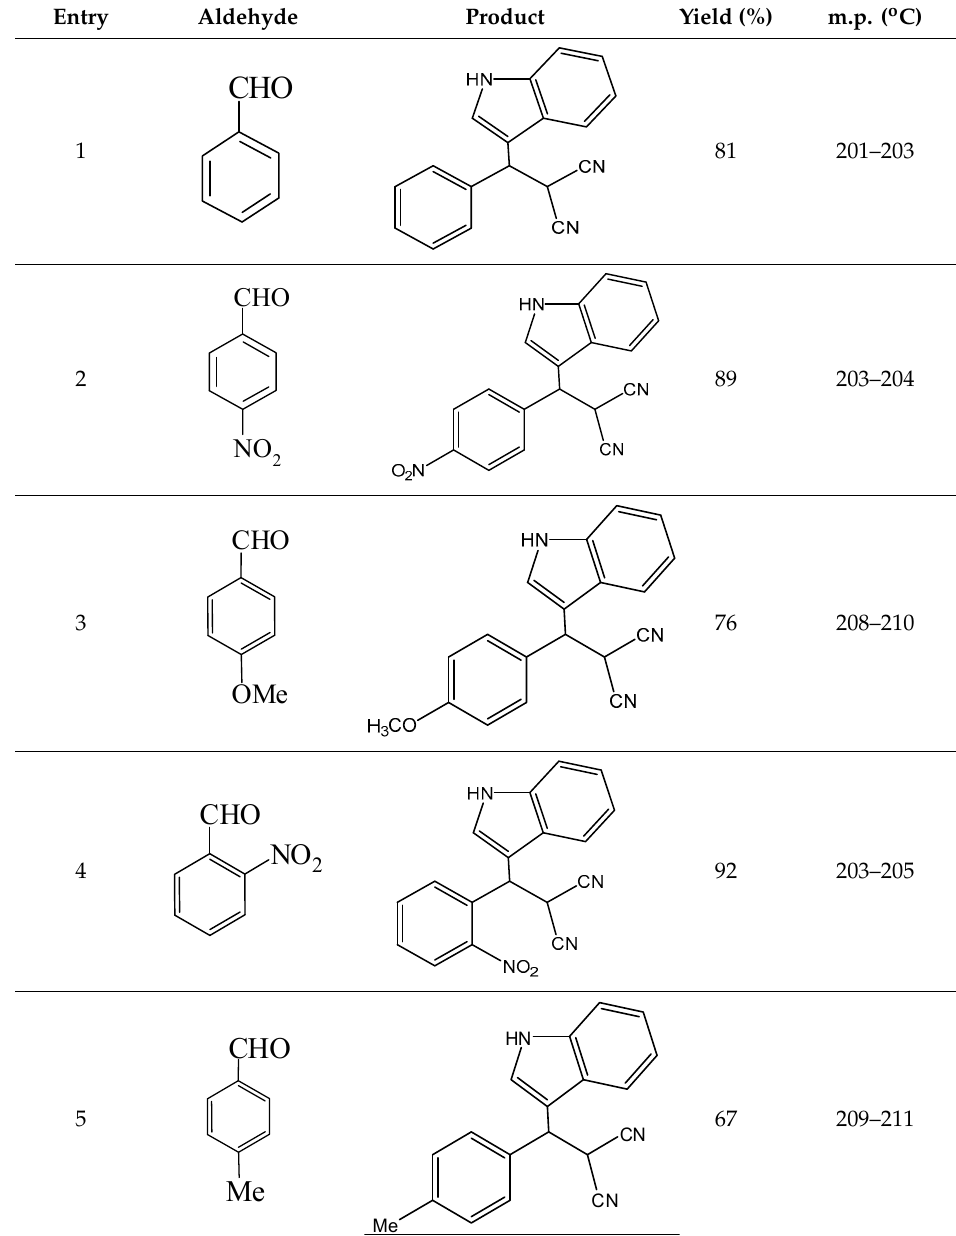
Table 3. Three-component solventless condensation of ethyl acetoacetate, urea and aromatic aldehydes catalysed by 51.6 wt % HPW/SBA-15.